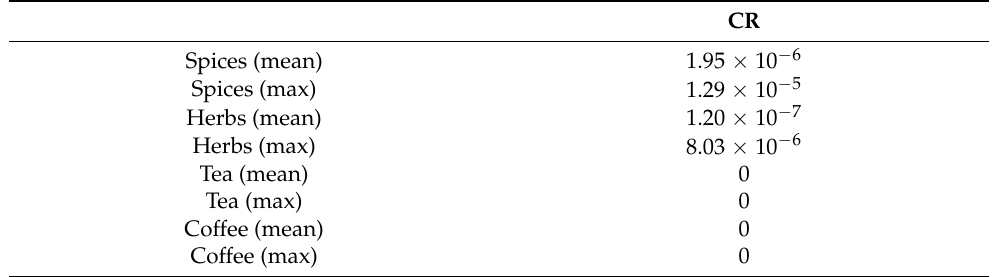
Table 4. The carcinogenic risk (CR) assessment related with the consumption of investigated